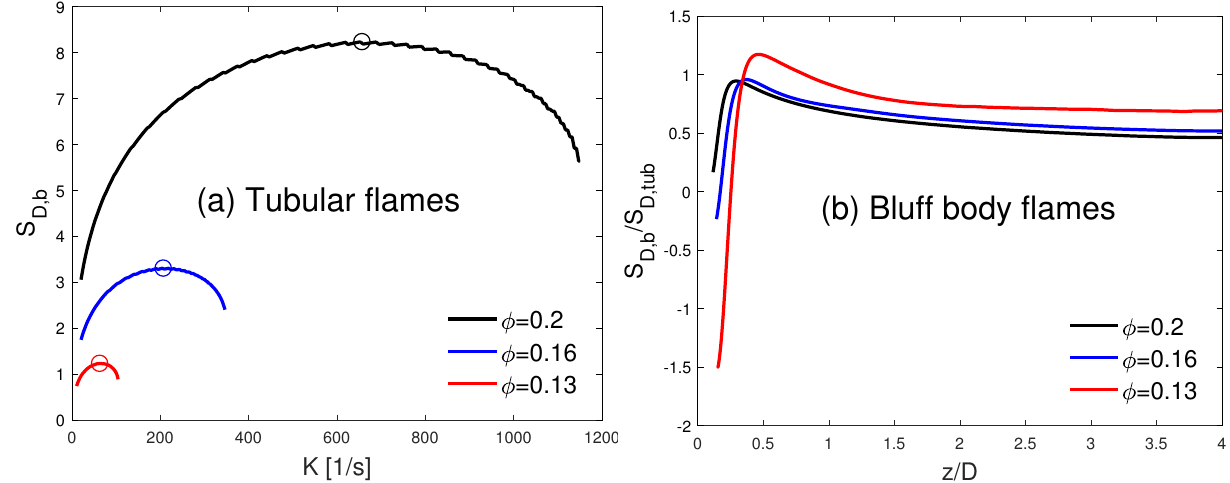
Figure 7. ( a ) S D , b at the inner layer of the flame for 1D tubular premixed flames at φ = 0.2,0.16,0.13 as a function of stretch rate. The maximum flame speed S D , tub is marked with ◦ symbol for each curve. ( b ) Flame displacement speed for bluff body stabilized flames scaled with maximum displacement speed of corresponding tubular flame S D , tub for φ = 0.2,0.16,0.13 at Y = 0.8